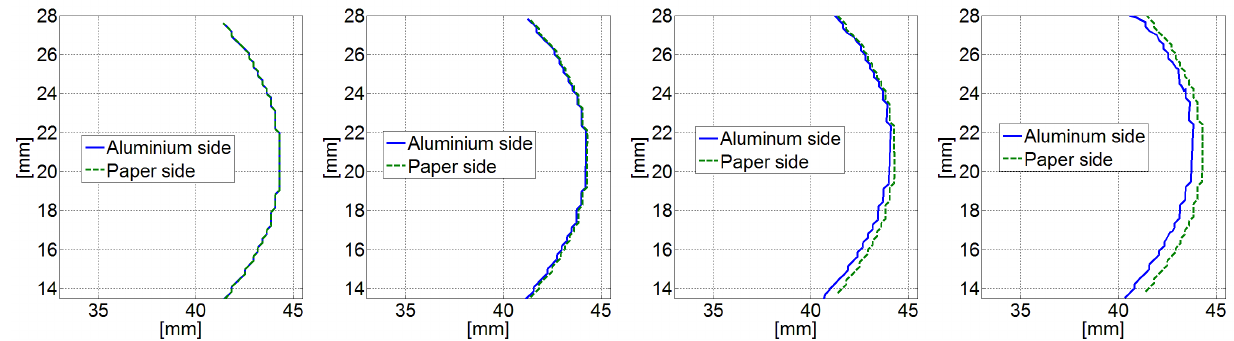
Figure 9: Recovery of the relative displacements during material separation from images 7, 22, 27, 32 (left to right).